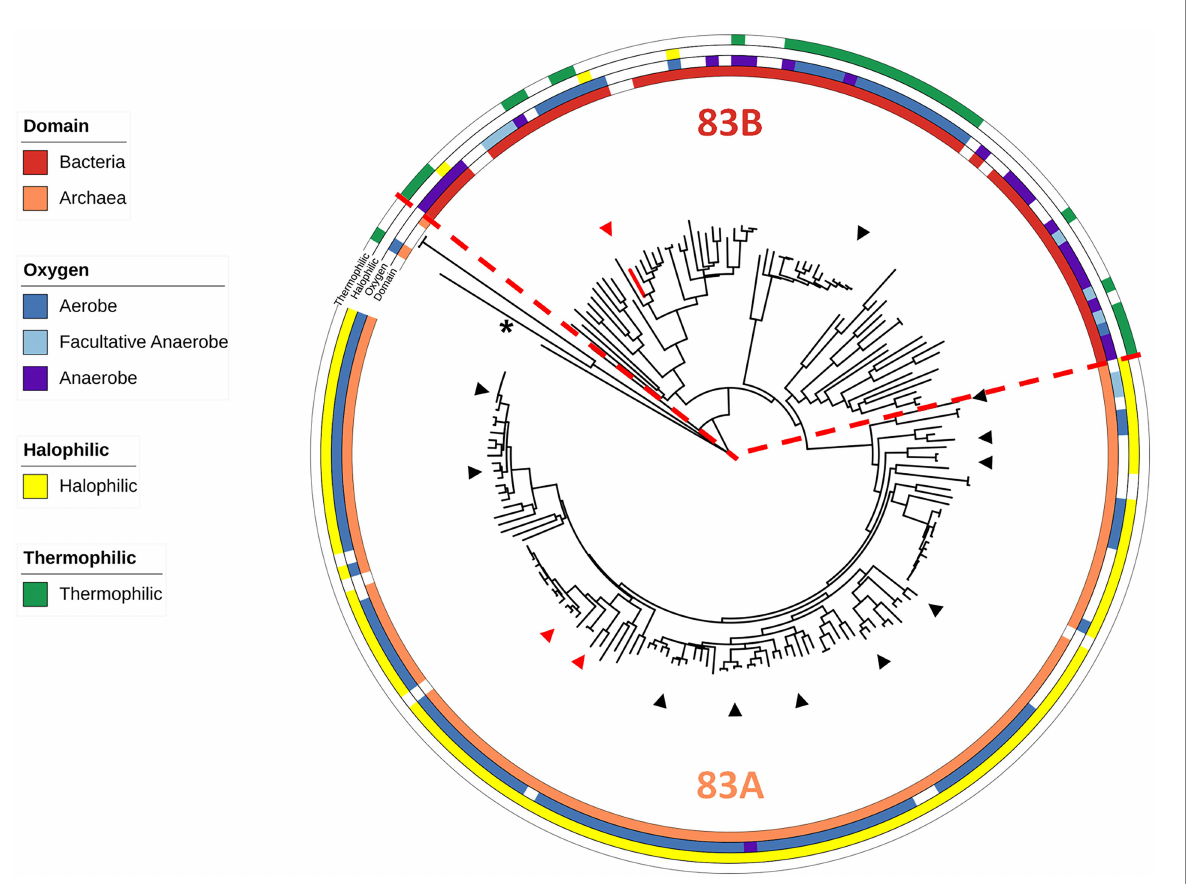
FIGURE 1 Characteristics of WOR Clade 83 organisms. An expanded and modified view of the previously published Clade 83 member proteins (Schut et al., 2021), now showing the domain of the host organism and their oxygen, temperature and salt requirements (see Supplementary Table S1). The red dotted line marks a point of phylogenetic divergence between the Archaea and Bacteria. B. massiliensis WOR is colored red and P. furiosus AOR from Clade 87 (Schut et al., 2021) was used as the outgroup (shown by the asterisk). Red triangles represent human gut microbiome-related organisms while black triangles represent food-related